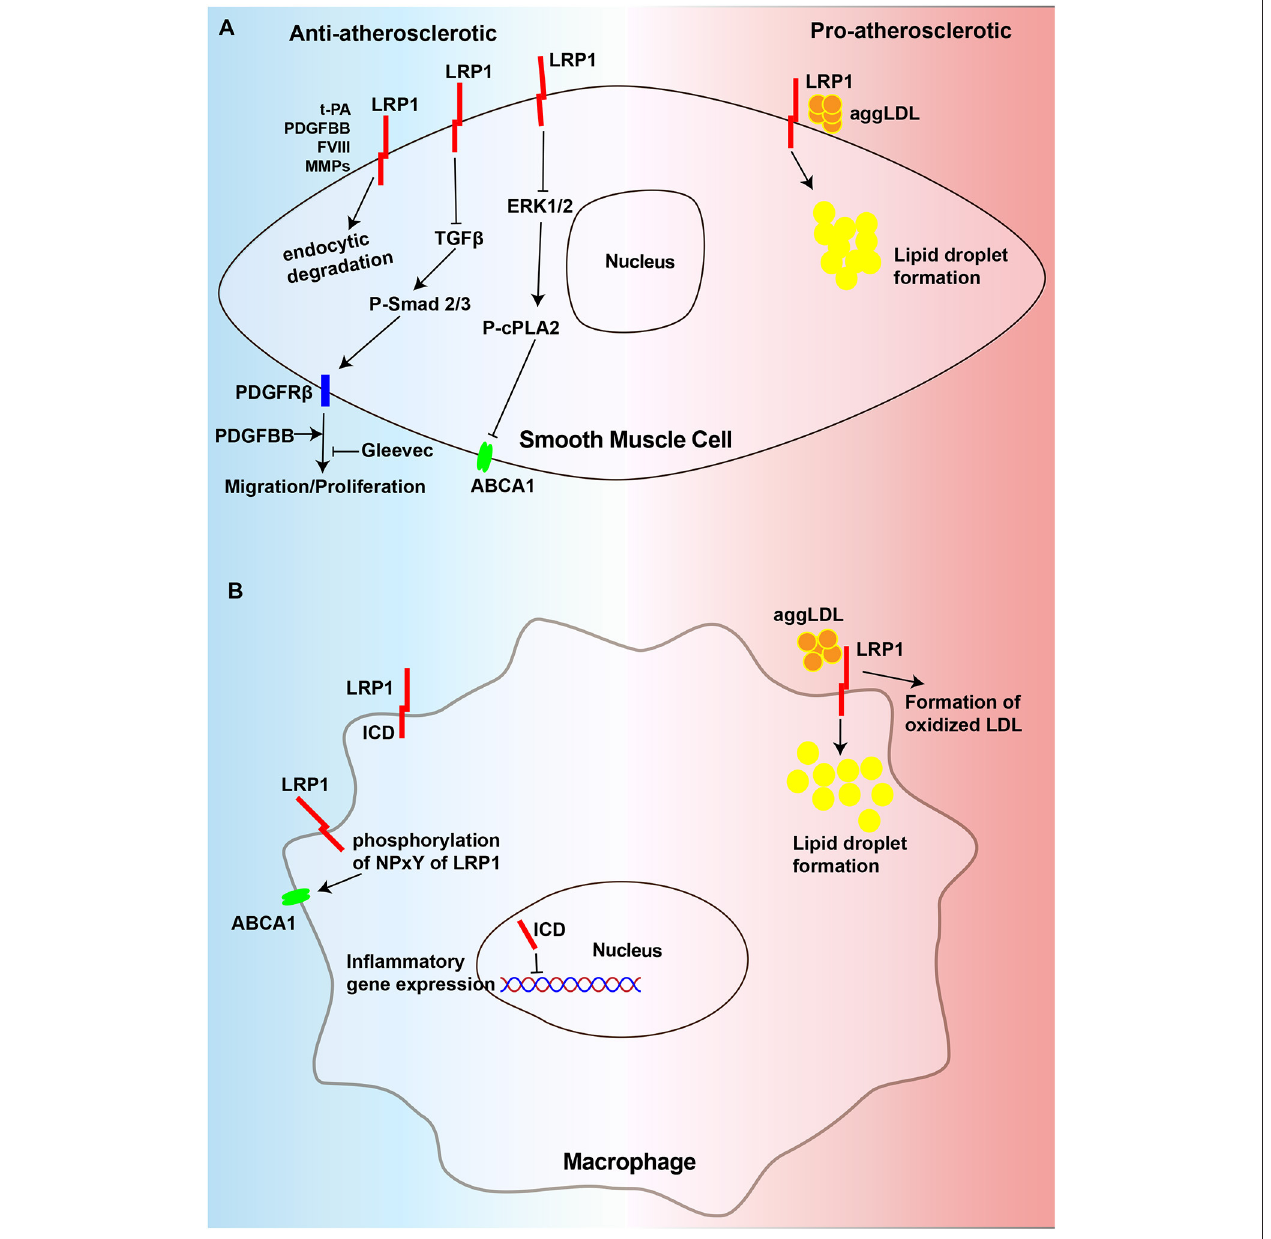
FIGURE 2 | Diagram of the mechanism of regulating atherosclerosis of LRP1 in VSMCs and macrophages. (A) LRP1 in VSMCs could degrade extracellular PDFGBB, MMPs, t-PA, and FVIII, which are atherogenic factors, in the way of endocytosis to play the role of anti-atherosclerosis. It could inhibit migration and proliferation of VSMCs to resist atherosclerosis by preventing the activation of TGF β /Smad2/3/PDGFR β signaling pathway. Gleevec could also has the effect to inhibit PDGFR β . Additionally, LRP1 inhibit the activation of ERK1/2 which could suppresses the expression of ABCA1 by promoting phosphorylation of cPLA2. In contrast, LRP1 in VSMCs accelerates the development of atherosclerosis by promoting the uptake of aggLDL and the formation of foam cells. (B) The LRP1 can also be cleaved by γ -secretase to release a 25-kDa β -chain fragment, which translocates to the nucleus to suppress inflammatory gene expression. The phosphorylation of NPxY of LRP1 ICD promotes the expression of ABCA1. Nevertheless, LRP1 in macrophages accelerates the development of atherosclerosis by promoting the uptake of aggLDL and the formation of oxidized LDL. AS, atherosclerosis, ABCA1, ATP-binding cassette transporter A1, cPLA2, cytosolic phospholipase